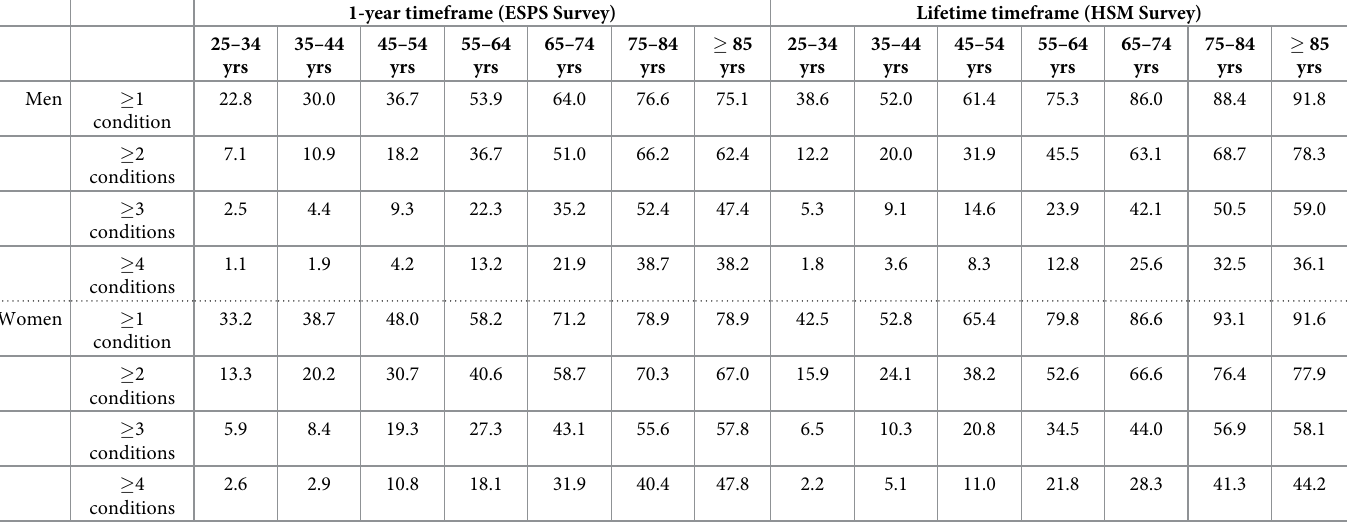
Table 2. Weighted frequencies of subjects presenting with � 1, � 2, � 3 and � 4 conditions in ESPS and HSM surveys. All estimates are weighted to represent French population estimates. 1-year timeframe (ESPS